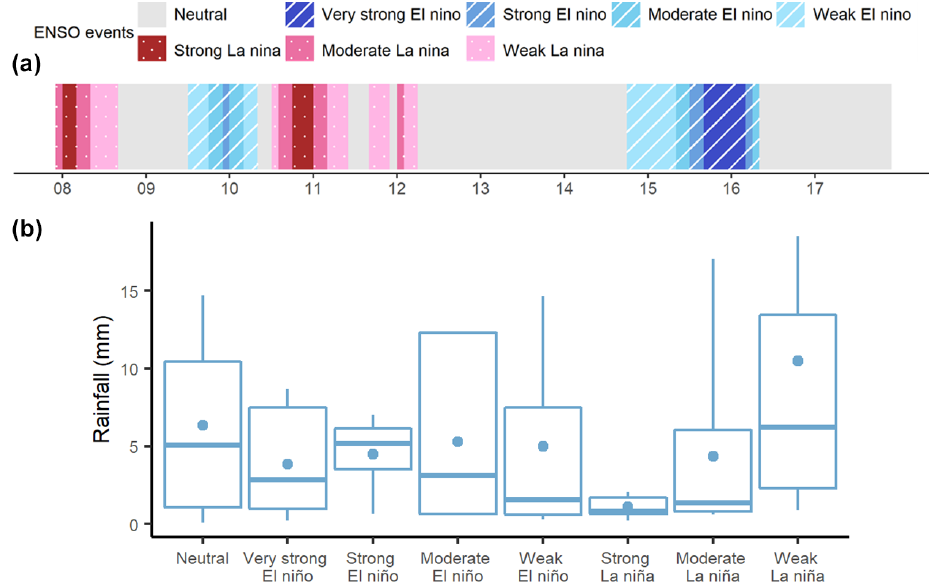
Figure 9. The temporal variation in strength of ENSO events in the 2008–2017 period (a) and the changes of rainfall (b) under different strength levels of ENSO